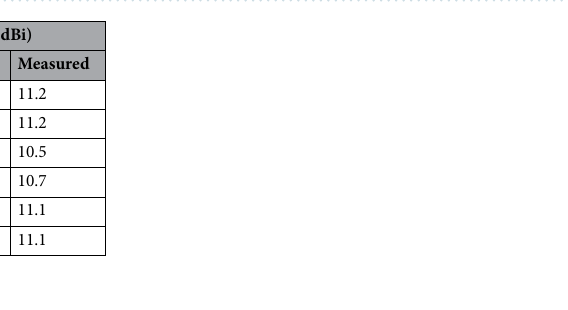
frequency band. Other performance metrics of the MIMO system are according to the standard. Polarization diversity is introduced in the MIMO system by incorporating the Pin-Diodes. Design work as a linearly polarized system when diodes are OFF and RHCP when diodes are ON. The design is fabricated to validate the simulated results. The simulated performance parameters of MIMO are in accordance with the experimental results.